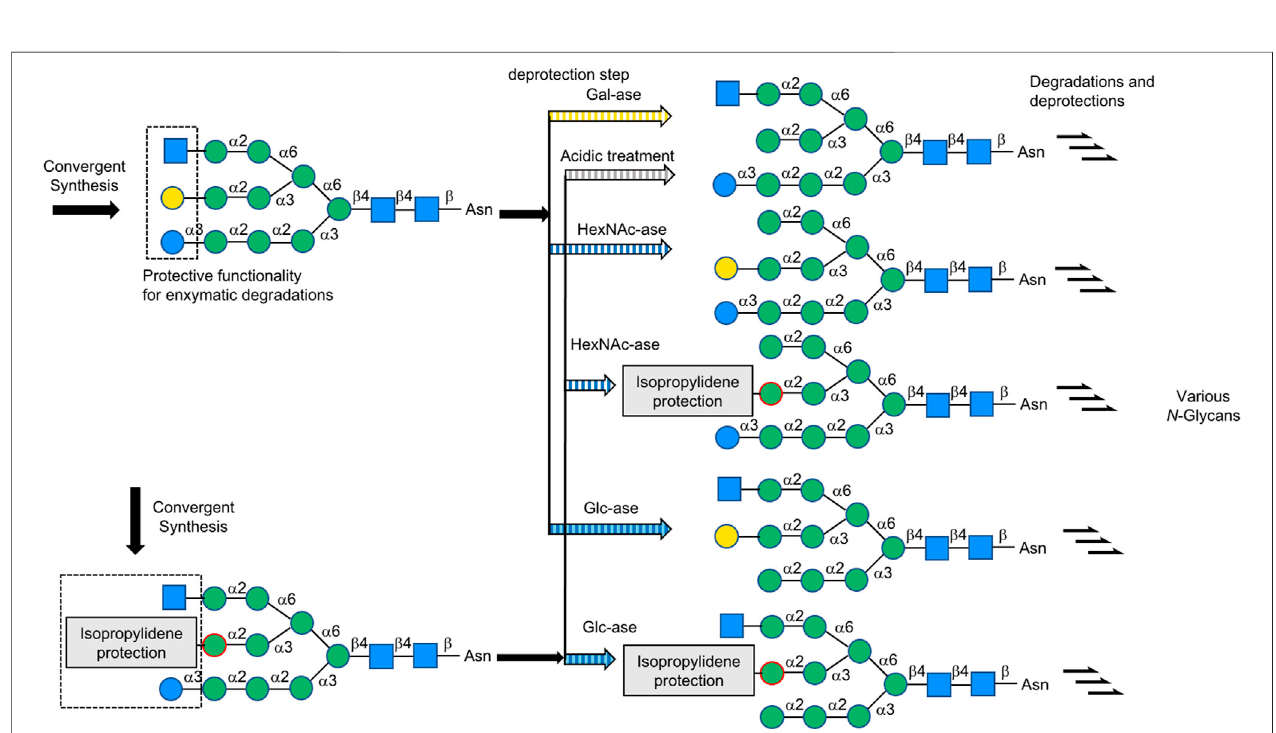
FIGURE 8 | Top to down strategy for complex-type N